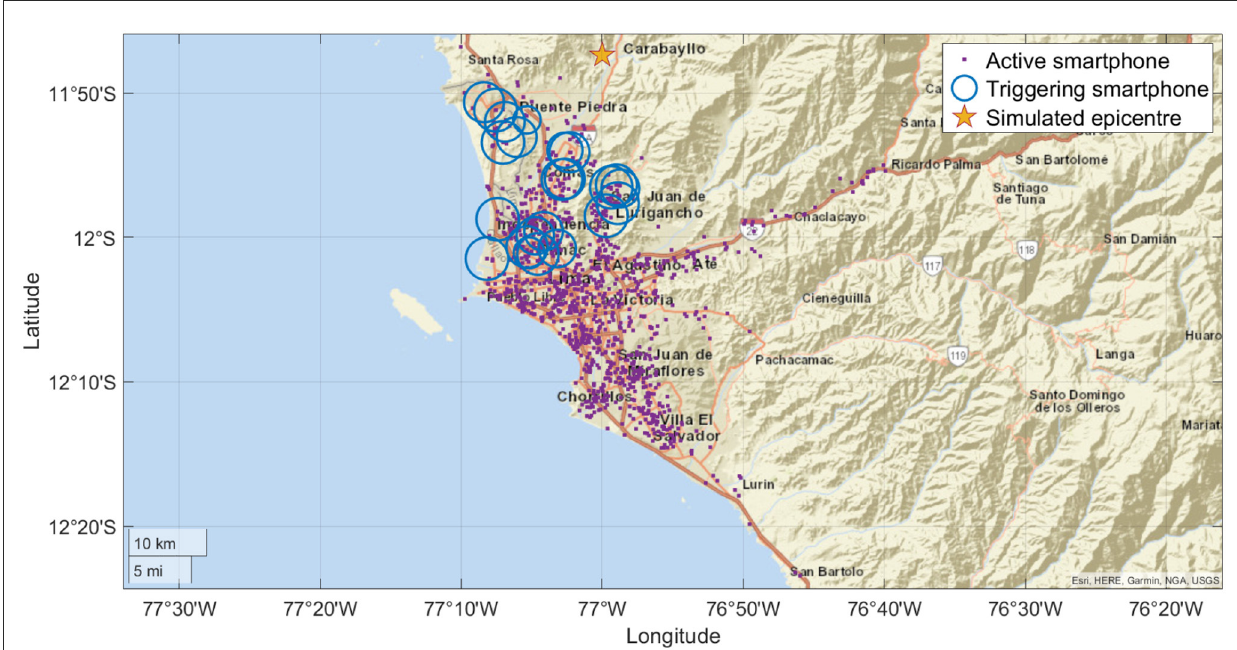
FIGURE1 Simulated true earthquake detection based on the EQN smartphone network of Lima (Peru). The diameter of circles is proportional to the triggering time.